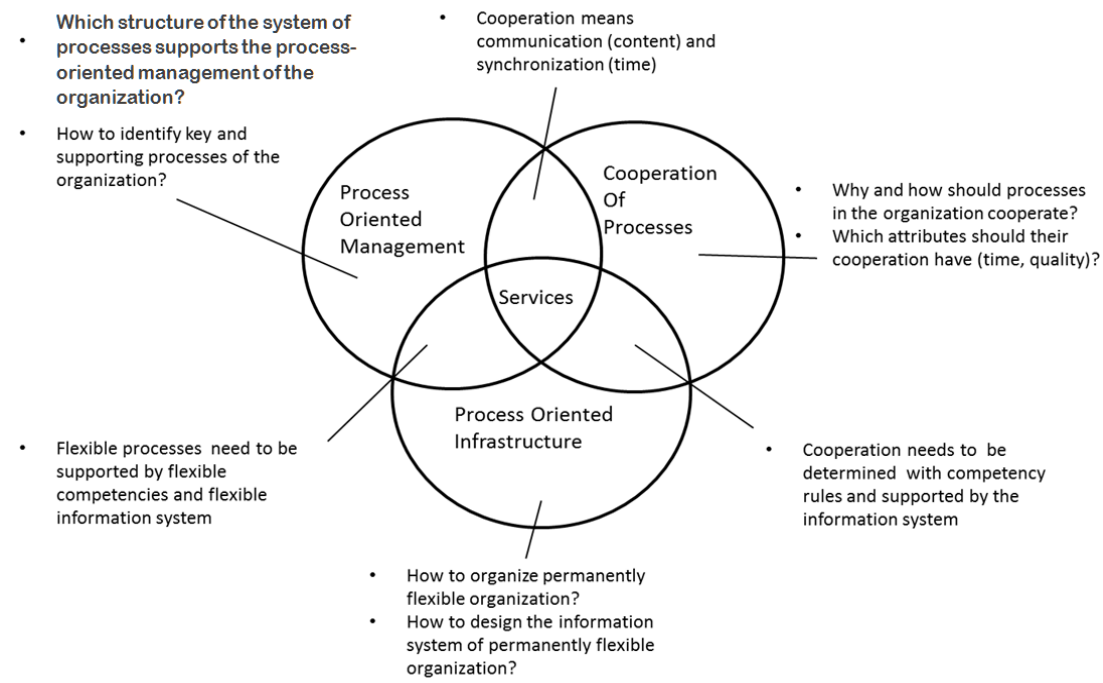
Figure 3. Service as a common denominator of content, technical, and human aspects of the organization management